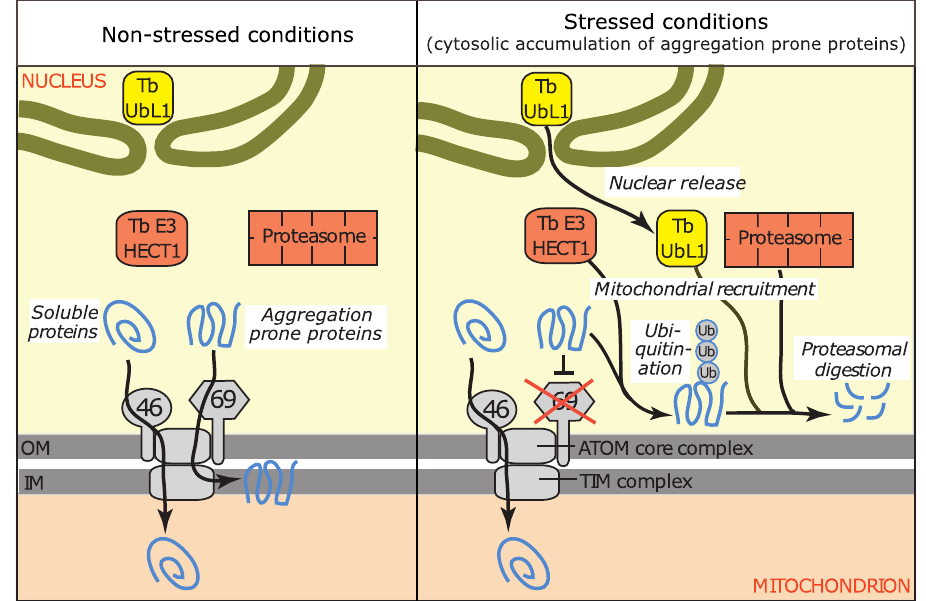
Fig. 9 Schematic model depicting the MQC pathway triggered by ablation of ATOM69 in trypanosomes. Ablation of atypical translocase of the outer membrane 69 (ATOM69) results in cytosolic accumulation of primarily hydrophobic proteins which triggers a quality control pathway that ultimately leads to the degradation of the mislocalised hydrophobic proteins. The pathway requires nuclear release of the ubiquitin-like protein 1, TbUbL1, the main subject of the present study (yellow). Moreover, TbUbL1, the ubiquitin ligase TbE3HECT1 (red), Tb927.9.7200 (not shown) and the proteasome (red) are recruited from the cytosol to the mitochondrion. The role of TbE3HECT1 may be to ubiquitinate the mislocalised hydrophobic proteins which subsequently may be recognised by TbUbL1 and transferred to the